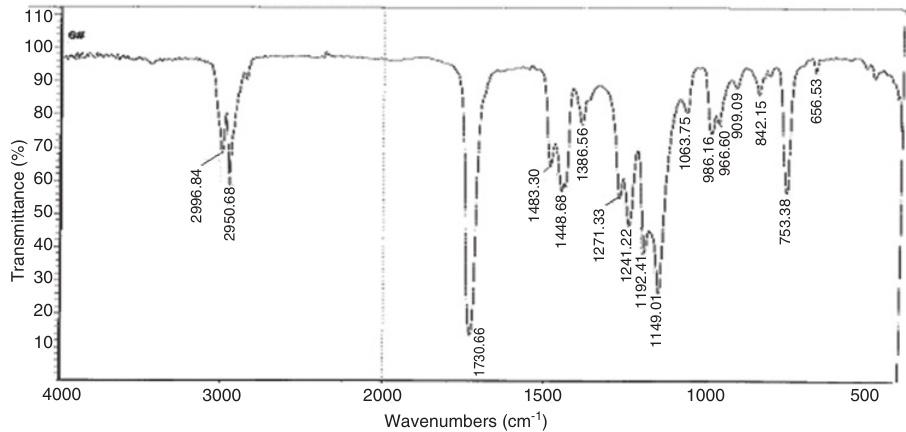
Figure 9: IR spectra of the sample without additive substance.